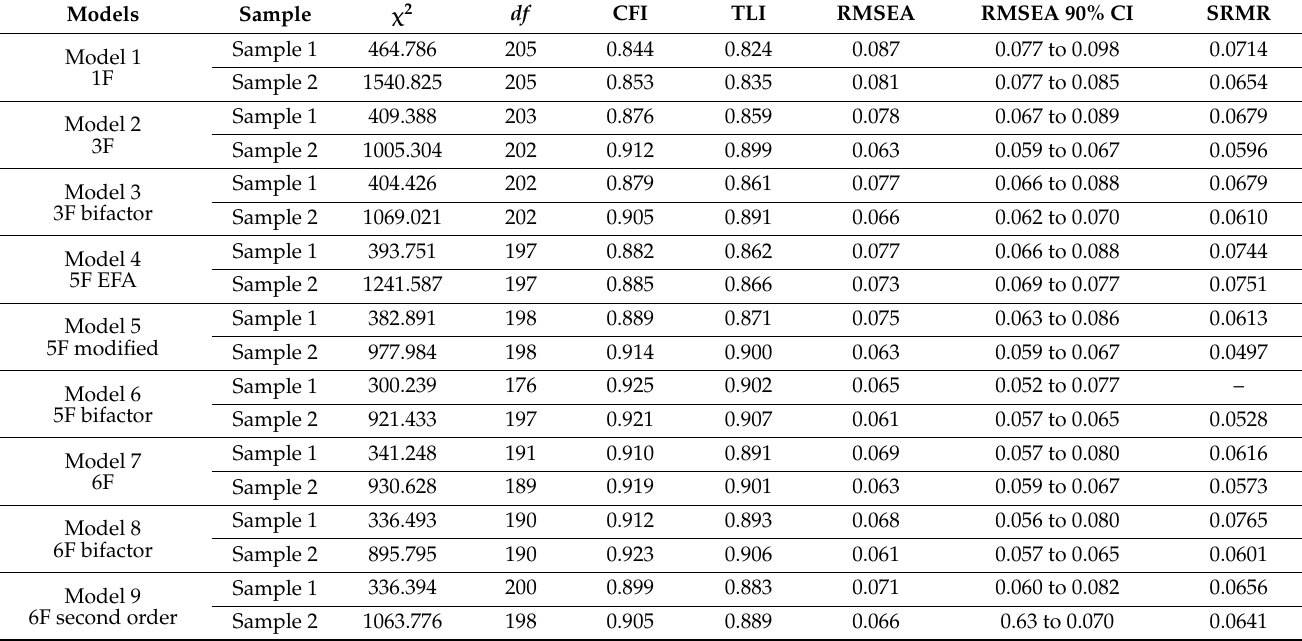
Table 3. Goodness-of-fit indices for models of the Arabic version of the Impact of Event Scale-Revised (IES-R) tested by confirmatory factor analysis in psychiatric patients and healthy